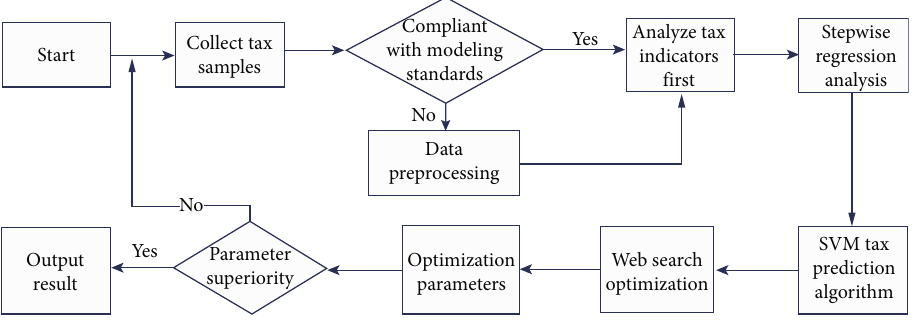
Figure 2: Network search optimization prediction process.